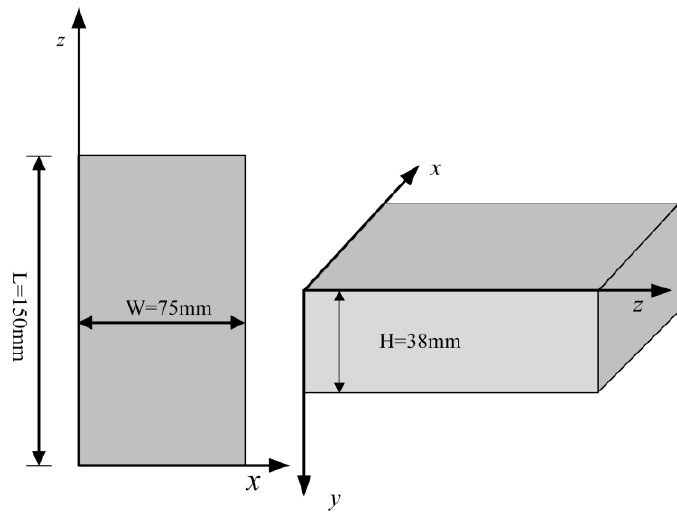
Figure 2. Cutting Figure 2. Cutting Template.